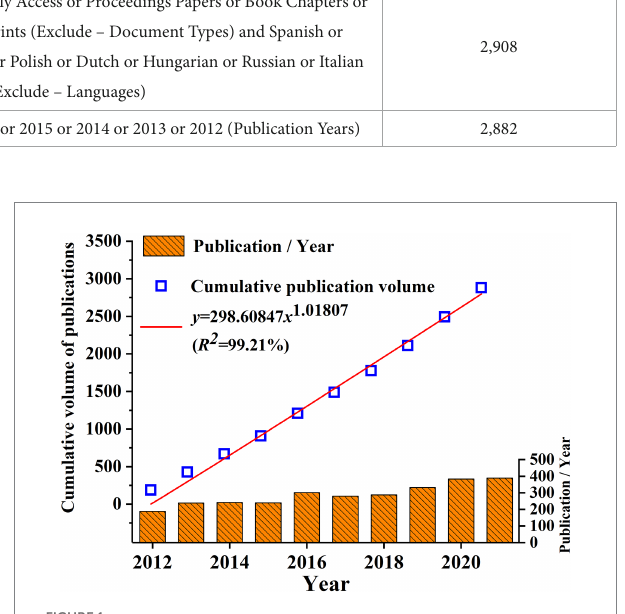
FIGURE 1 Annual trend of Physiology teaching reform research.